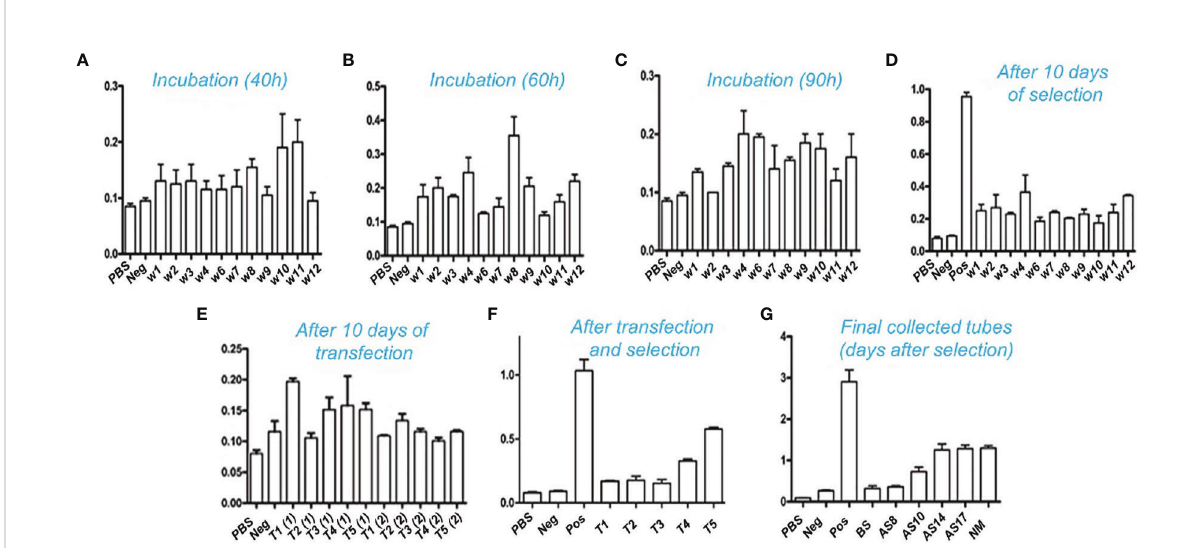
FIGURE 5 Af fi nity determination with ELISA: Binding interaction of the antibody with PD-L1 antigen after transfection and selection. Positive transformed cells were selected and remained incubated for up to 10-14 days. Cultural supernatants were taken from fi ve different wells. The transfection processes were repeated twice in triplicate for each. High titer clones were further selected for 96 wells plates to isolate the single positive clones. (A – C) show the incubation time of a single clone selection. A total of 12 clones were selected after 96 wells plates single cell inoculation. These clones were further utilized for expression and puri fi cation. (D) shows an intermediate collection after 10 days of selection and (E) indicates collection after 10 days of transfection. The high-af fi nity titer supernatant was selected and tested for binding through ELISA as shown in (F) . (G) : indicates the overall results of collected supernatant up to 17 days of incubation transformed CHO cells into serum-free media. BS: Before selection, AS: After selection, Pos: Positive, NM: indicates results after puri fi cation through the Protein A resin